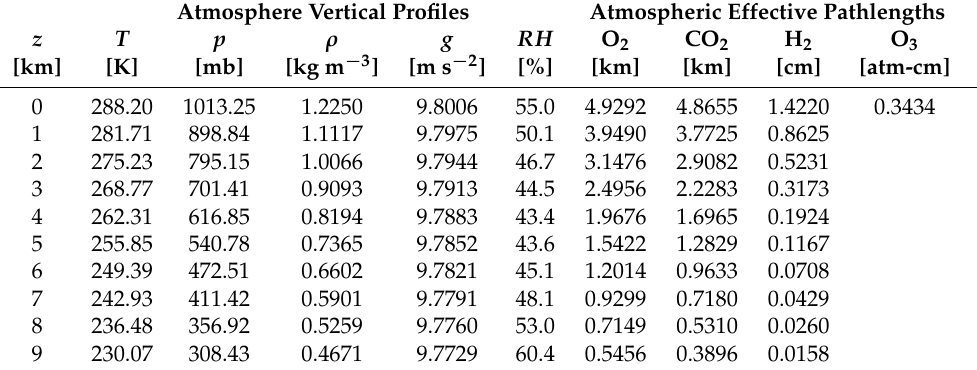
Table 2. Vertical profiles and effective pathlengths for the U.S Standard Atmosphere at latitude 35 ◦ 14 (cid:48) 17.904126 (cid:48)(cid:48) . Parameters in the table represent altitude ( z ), temperature ( T ), pressure ( p ), density of dry air ( ρ ), gravitational acceleration ( g ), relative humidity ( RH ), oxygen (O 2 ), carbon dioxide (CO 2 ), precipitable water (H 2 O), and ozone (O 3 ). The latitude location represents the center of the study area scene. Atmosphere Vertical